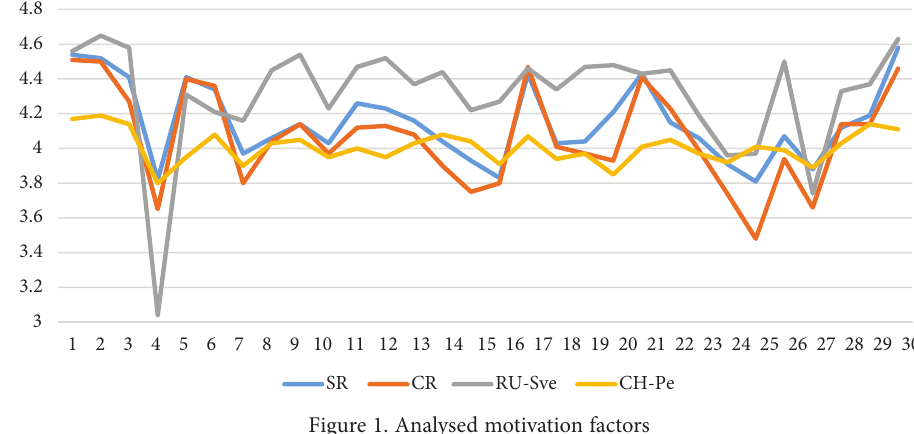
Figure 1. Analysed motivation